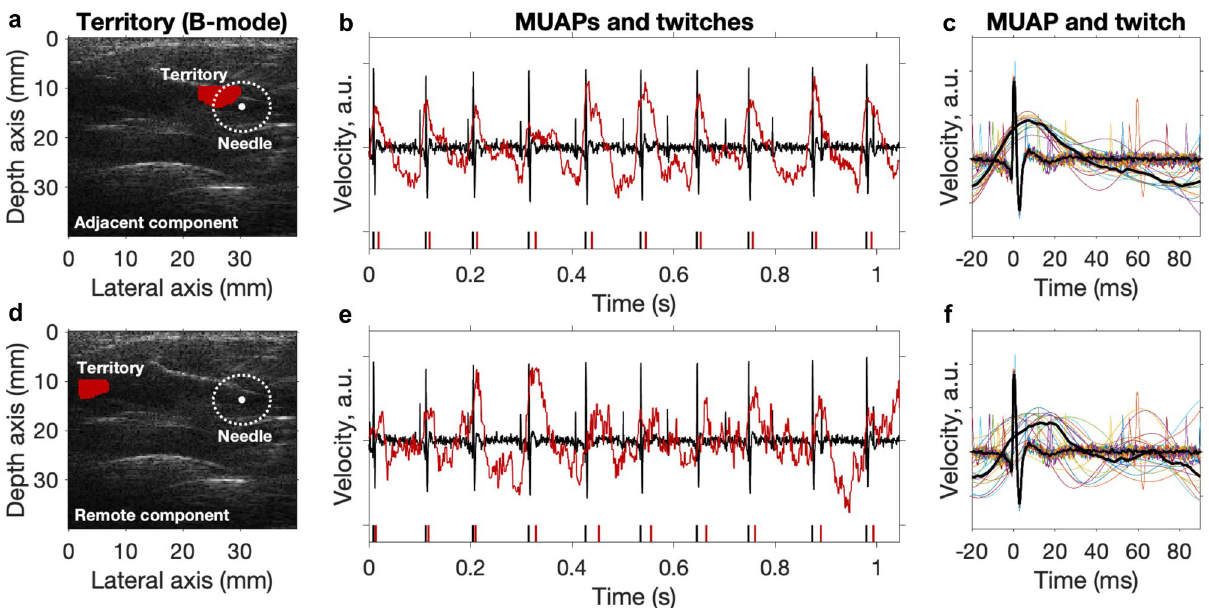
Figure 5. Observation of similar RoA and twitch CoV indicate distributed MU territory (for the same MU). ( a , d ) Components’ MU territory (red region) of biceps brachii cross-section for one subject with an adjacent and remote component. The white dotted circle corresponds to the concentric needle uptake area. ( b , e ) The MUAPs (black), components’ twitches (red), and their corresponding firing patterns below (black and red vertical lines). ( c , f ) The spike-triggered averaged mechanical twitches given the MU firing pattern (from